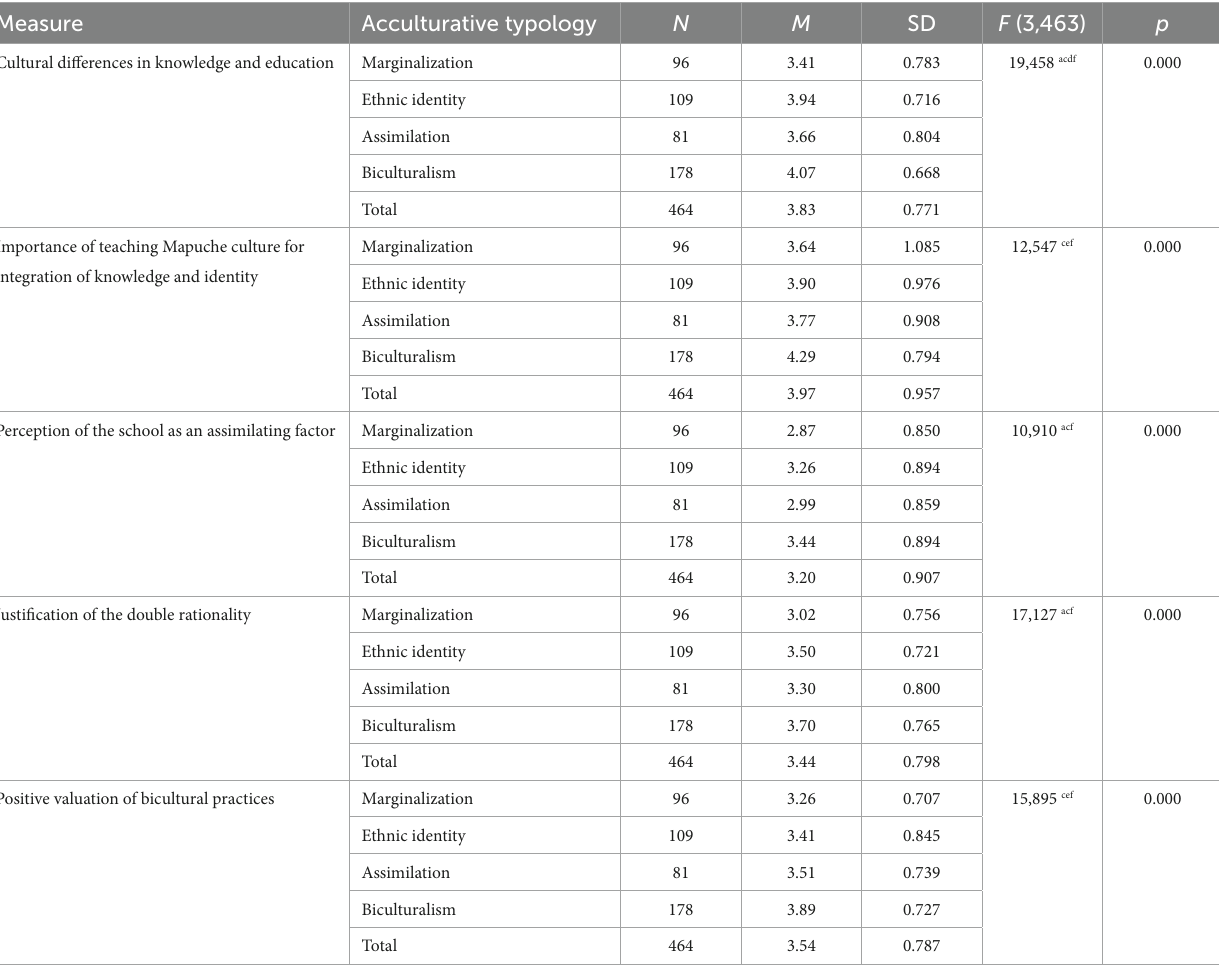
TABLE 1 Means, standard deviations, and One-Way analyses of Variance in the dimensions of attitudes toward school education.